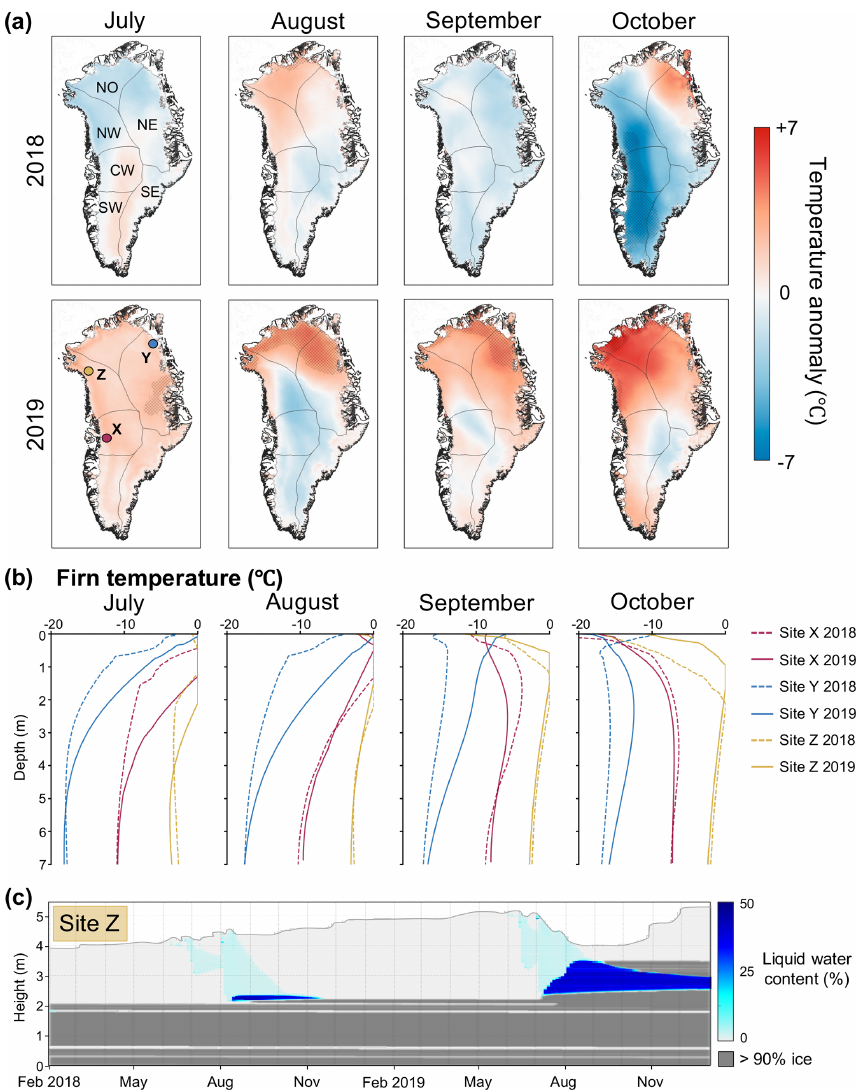
Figure 7. Air and subsurface firn temperature modelling analysis. (a) The 2018 to 2019 mean monthly temperature difference for July, August, September, and October from left to right. Areas with temperature anomalies that are significantly different from the climatology at the 95% confidence level are shaded with a cross-hatch pattern. (b) Subsurface firn temperature profiles at sites X (CW Greenland), Y (NE Greenland), and Z (NW Greenland) for July, August, September, and October from left to right. (c) Subsurface firn temperature profiles at site Z (NW